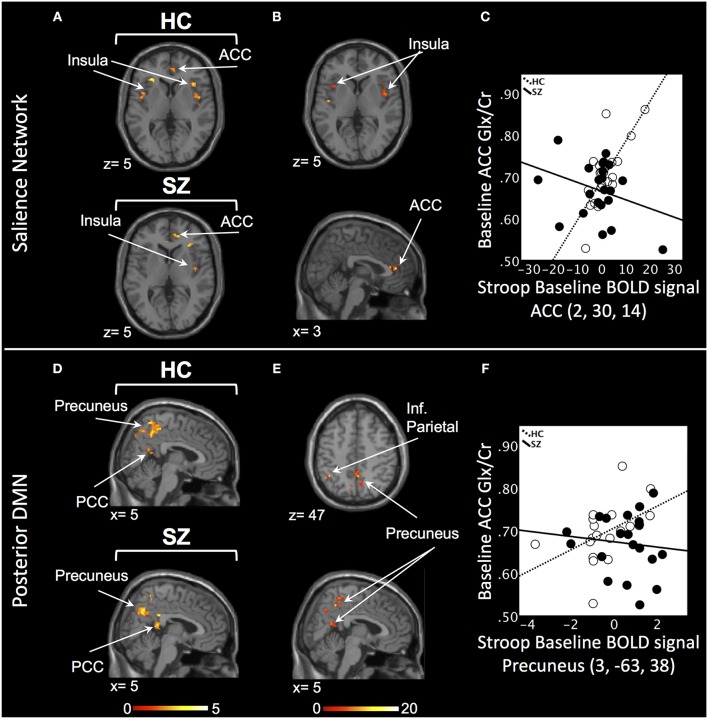
Baseline relationship between ACC Glx and Stroop BOLD signal. (A) In the salience network, relationship between Glx levels and Stroop BOLD signal in healthy controls (HC) and off-medication patients with schizophrenia (SZ) in the ACC and insula. (B) Baseline BOLD Stroop group × ACC Glx interaction significant in bilateral insula and ACC in the salience network. (C) Descriptive plot of ACC Glx and ACC Stroop BOLD signal (MNI coordinates 2, 30, 14) reflecting the significant positive correlation in HC and the lack of correlation in off-medication SZ. (D) In the posterior default mode network (DMN), relationship between Glx levels and Stroop BOLD signal in HC and off-medication SZ in the precuneus, posterior cingulate cortex (PCC) and inferior parietal lobule (Inf. Parietal). (E) Baseline BOLD Stroop group × ACC Glx interaction significant in the precuneus and inferior parietal lobule in the posterior DMN. (F) Descriptive plot of ACC Glx and Precuneus Stroop BOLD signal (MNI coordinates 3, −63, 38) reflecting the significant positive correlation in HC and the lack of correlation in off-medication SZ. x and z coordinates refer to Montreal Neurological Institute (MNI) space. Color bar on bottom indicates t-score. All analyses were thresholded at PSVC < 0.05.